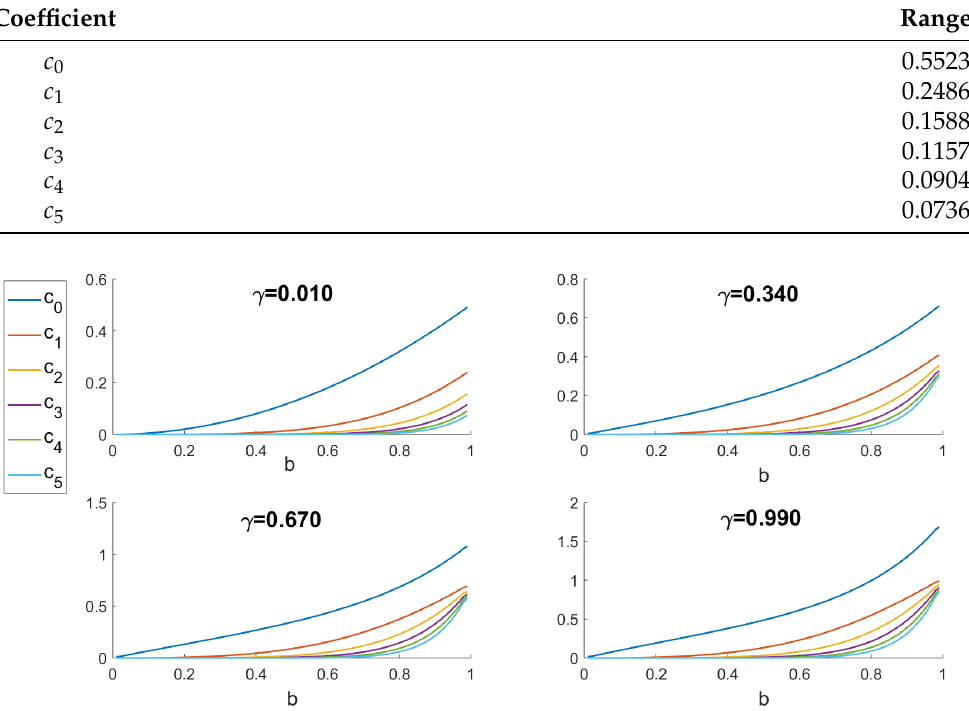
c n − min q ∈ F c n . h h